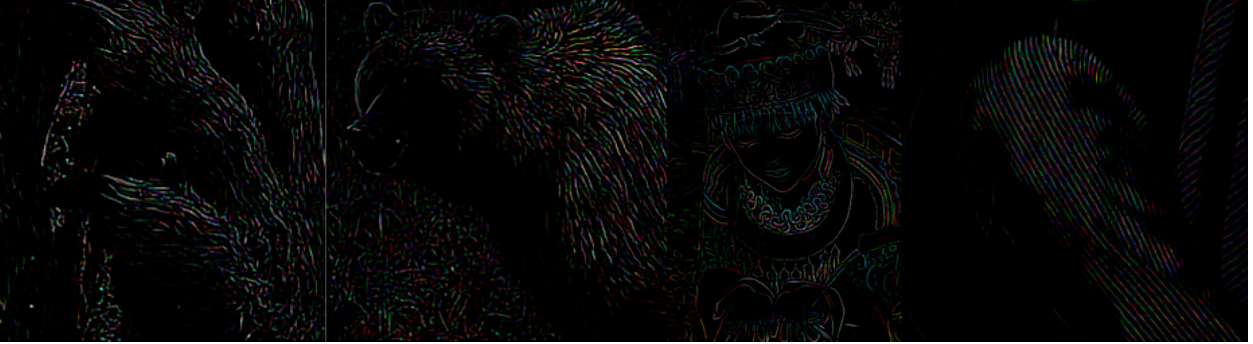
Figure 9. Laplacian maps predicted using ISMP.